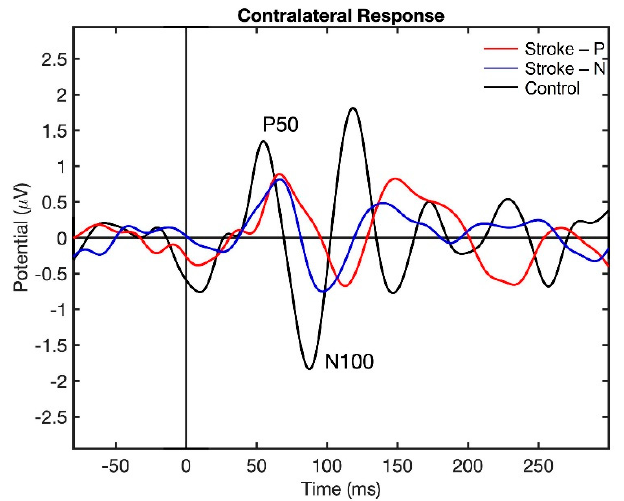
Figure 2. Contralateral Somatosensory Evoked Potential (SEP) response to finger stimulation. Stroke-P (red): paretic hand was stimulated. Stroke-N (blue): non-paretic hand was simulated. Control (black): dominant hand was stimulated.